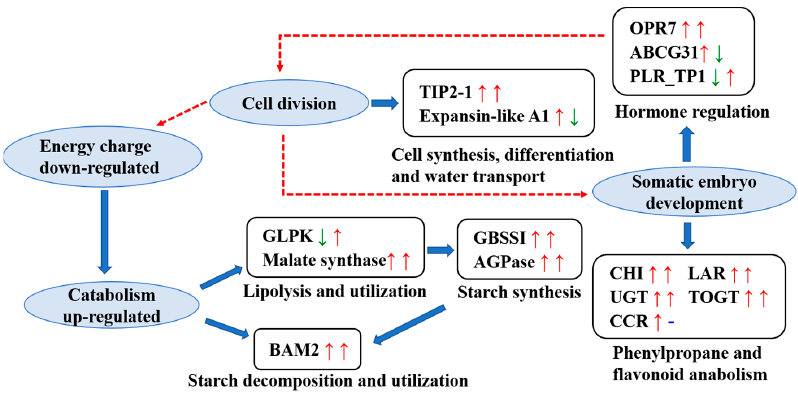
Figure 6. The key signaling pathways and proteins involved in SE in L. olgensis . The first arrow behind each protein represents its expression from PEC to SEM, and the second arrow represents its expression from SEM to CE. Up arrows indicate significant up ‐ regulation; down arrows indicate significant down ‐ regulation; and blue horizontal lines indicate neither up ‐ regulation nor down ‐ regulation. Dotted red lines indicate indirect action.